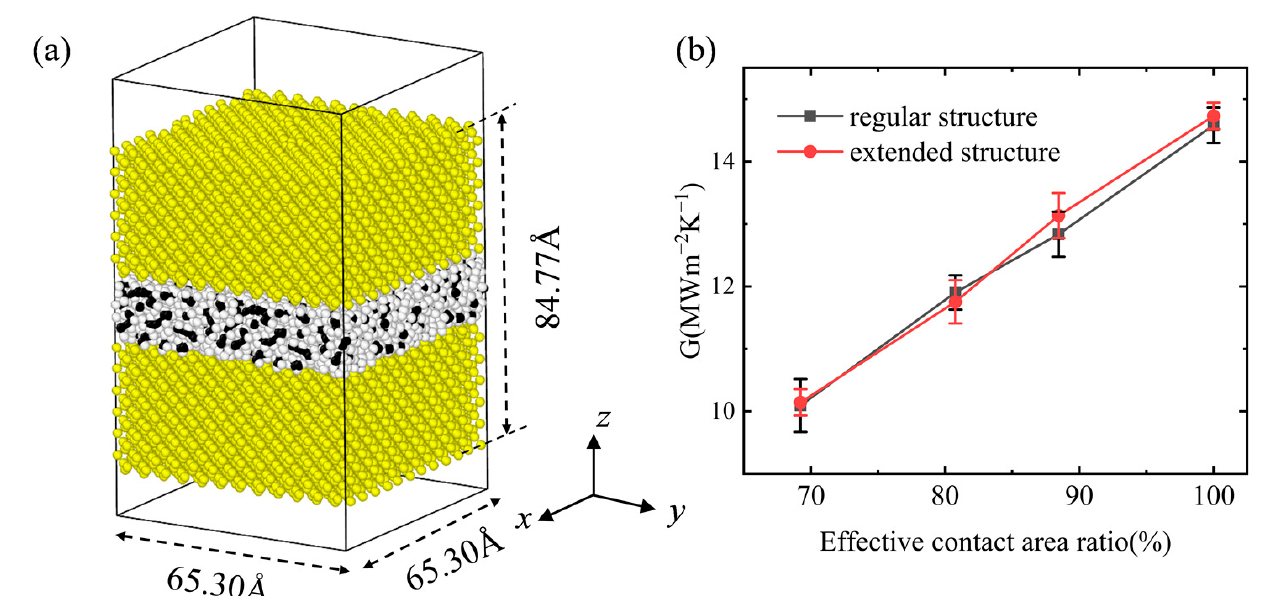
Figure 3. ( a ) Another model that increases the width in both the x and y directions. ( b ) The relationship between the interfacial thermal conductance and the effective contact area ratio of the two models at 500 K shows that there is basically no size effect.